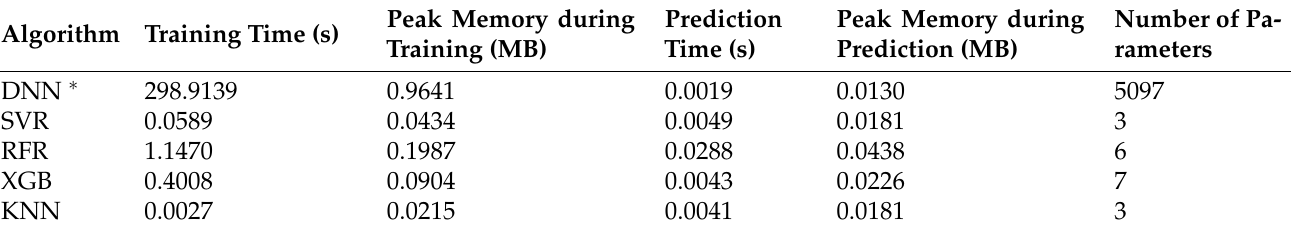
Table 4. Results of baseline comparison of the training time, memory demand, prediction time, and number of parameters. ( ∗ denotes the proposed